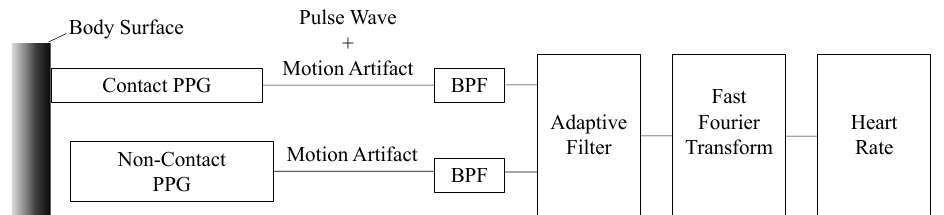
Figure 3. Principle of motion artifacts